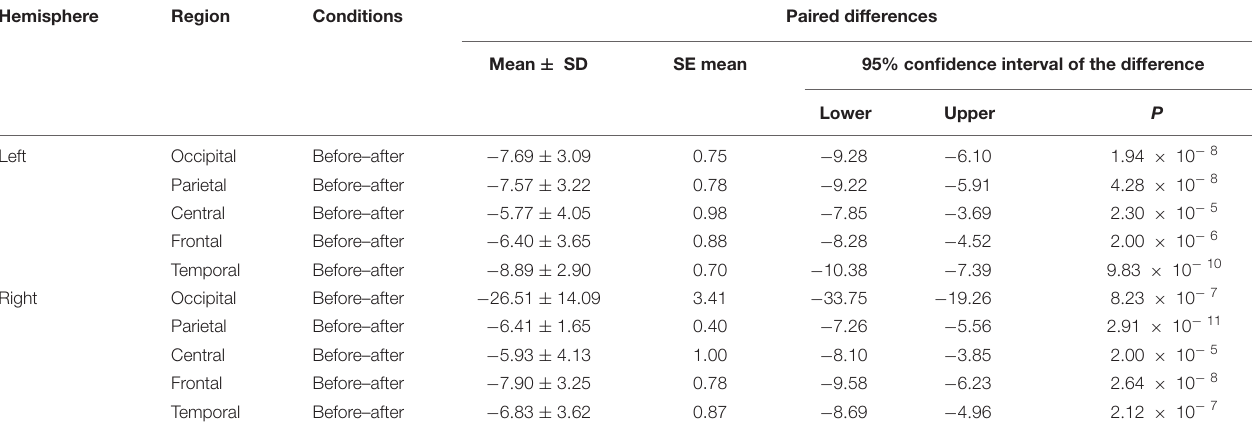
TABLE 3 | The results of paired t -test for average alpha power before and after each regional condition for anxious subjects.